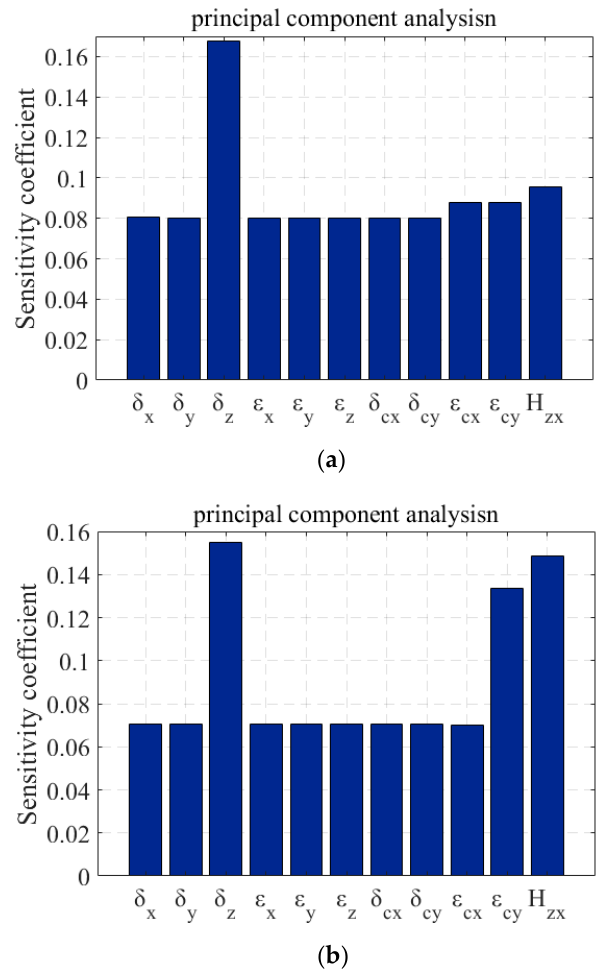
Figure 3. The contribution of different error components : ( a ) To form distortion; ( b ) To wavefront increment.